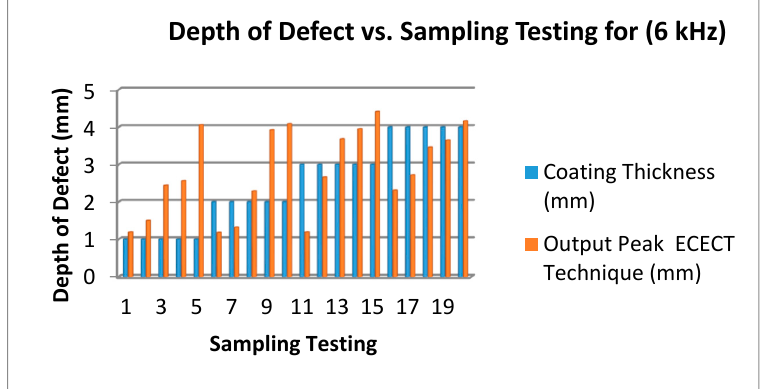
Figure 15. Depth of Defect (mm) vs. Testing Sampling (6 kHz Frequency).